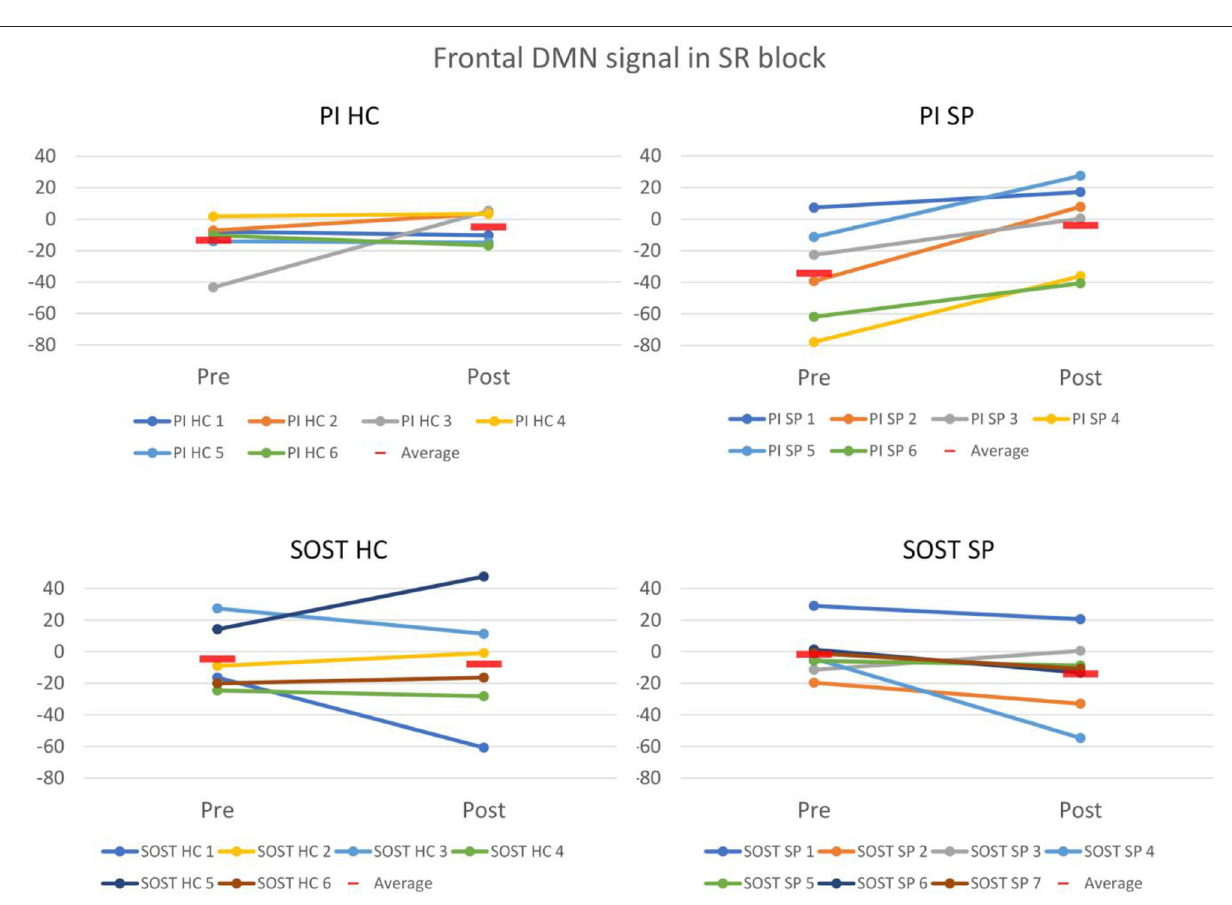
preserved activity in left frontal regions along with less memory complaints usually observed in healthy controls suggest that memory improvement in the control groups would not require a